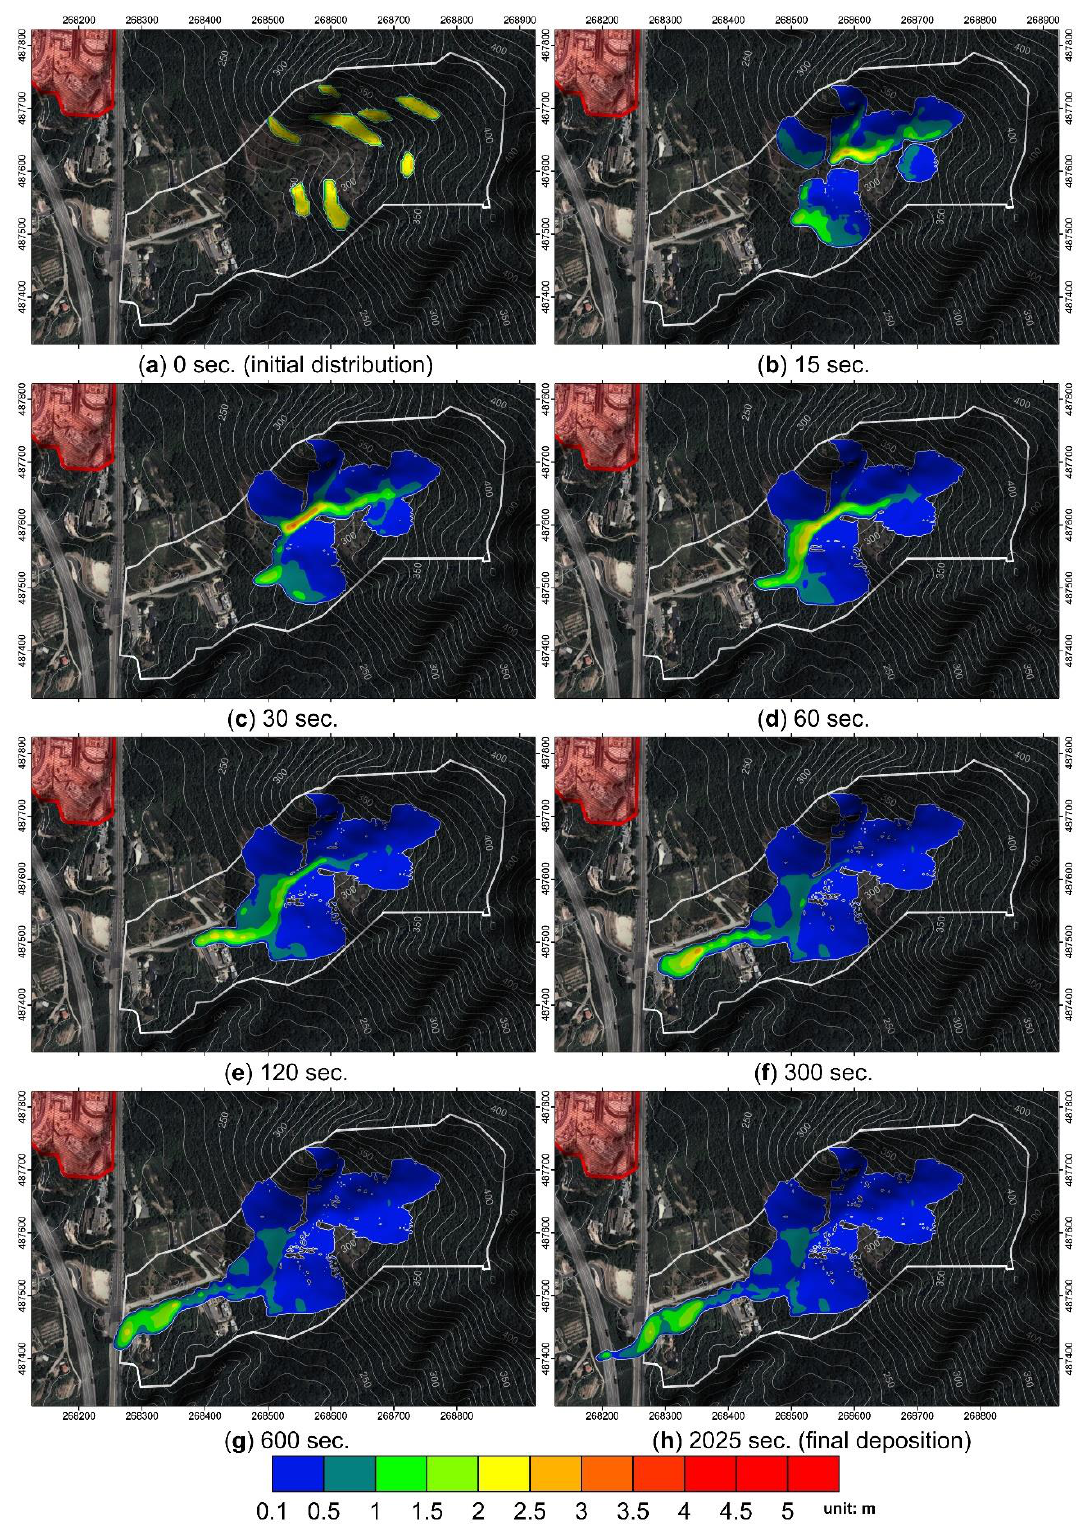
Figure 15. Simulated flow and thickness of debris at different times (( a )~( h )) Watershed D.